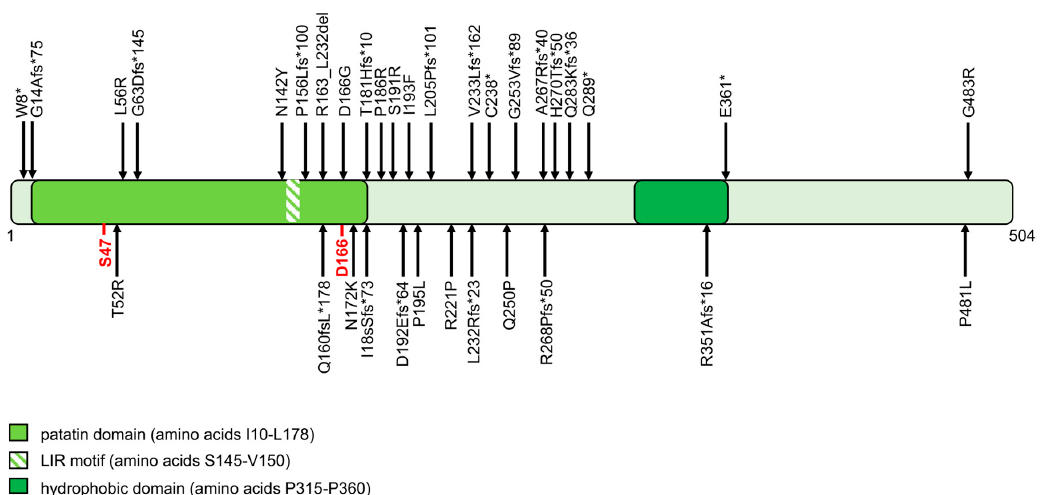
Figure 1. Structural domains of adipose triglyceride lipase (ATGL) protein and mutations identified in neutral lipid storage disease with myopathy (NLSDM) patients. The ATGL protein, consisting of 504 amino acids, comprises two functional regions: (i) the patatin domain, containing a catalytic site (S47 and D166, reported in red) and an LC3-interactinig region (LIR) motif; (ii) a hydrophobic region in the C terminal part, involved in lipid droplet (LD) binding. All ATGL protein mutations are reported in the scheme, based on recommendations for sequence variant description of Human Genome Variation Society (HGVS)-nomenclature website (http://varnomen.hgvs.org). Four PNPLA2 mutations that cause no protein production (c.553_565delGTCCCCCTTCTCG; IVS6 + 1G > T; IVS6 + 2T > C; retrotransposon insertion) are not shown in the